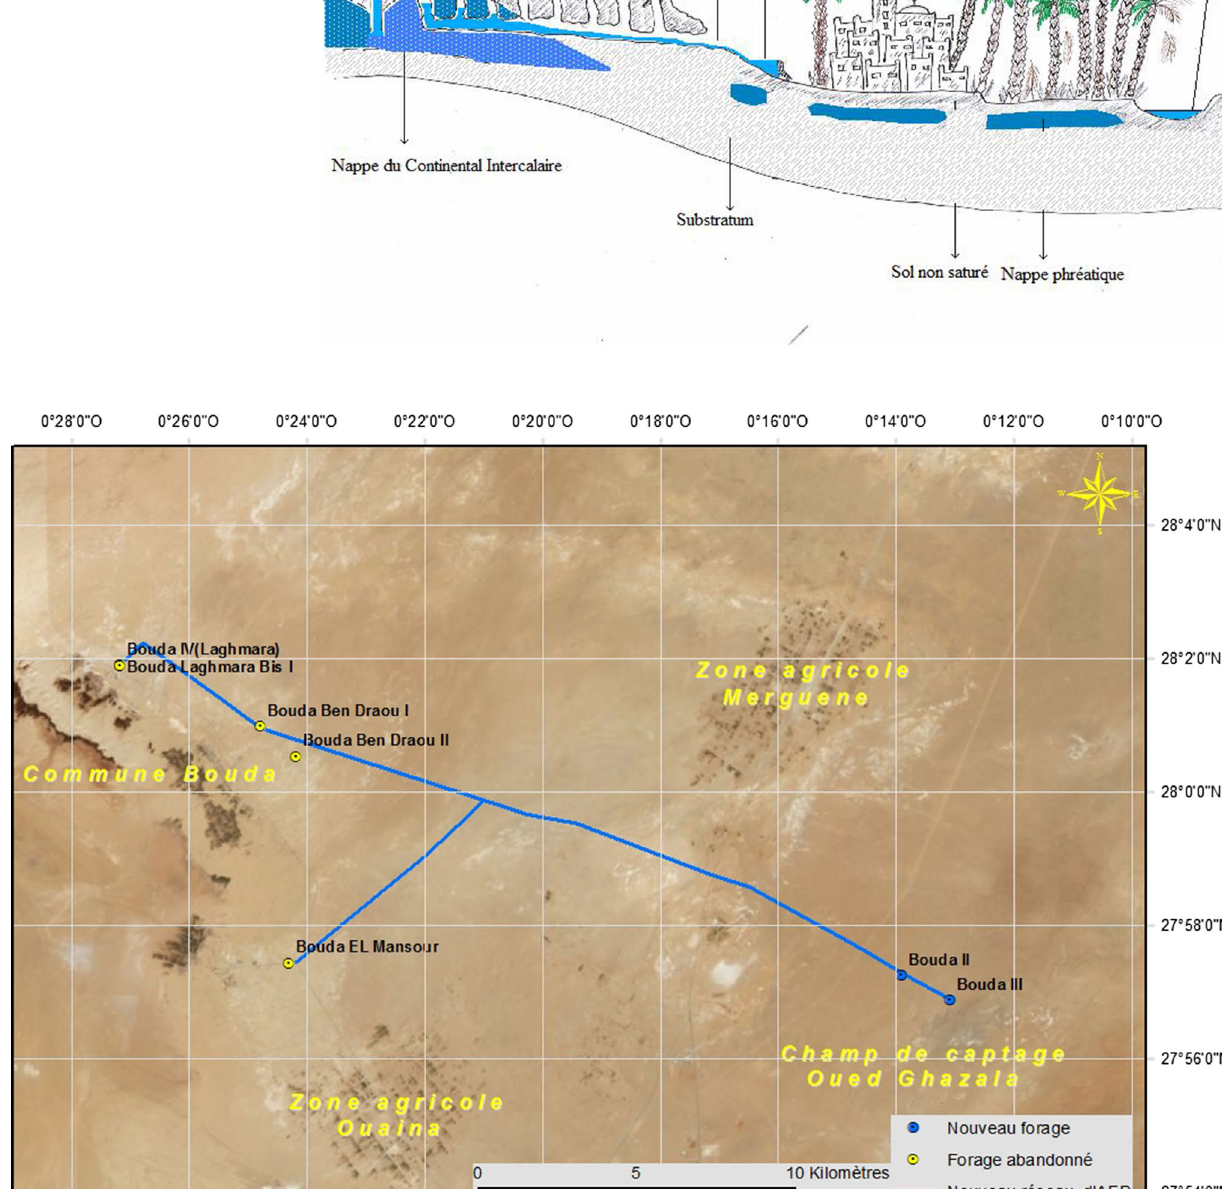
Fig. 9 Drilling situation and transfer of water to commune of Bouda. (own